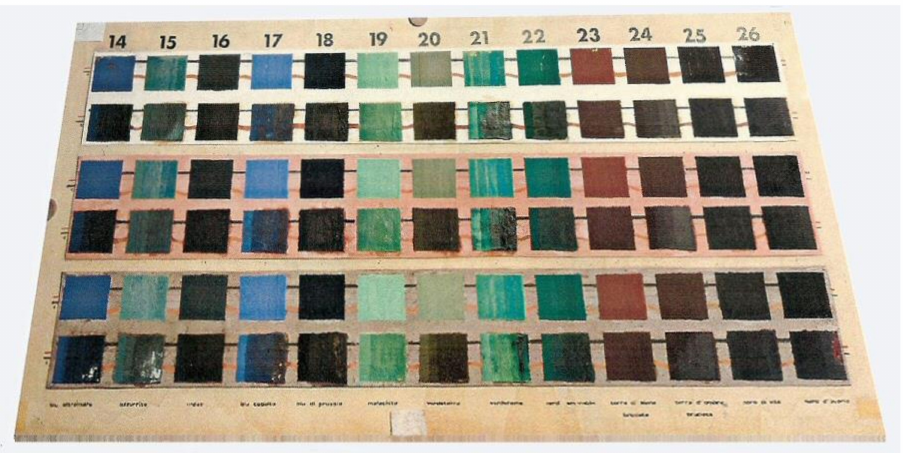
Figure 8. One of the Editech test panels analyzed using the FEL